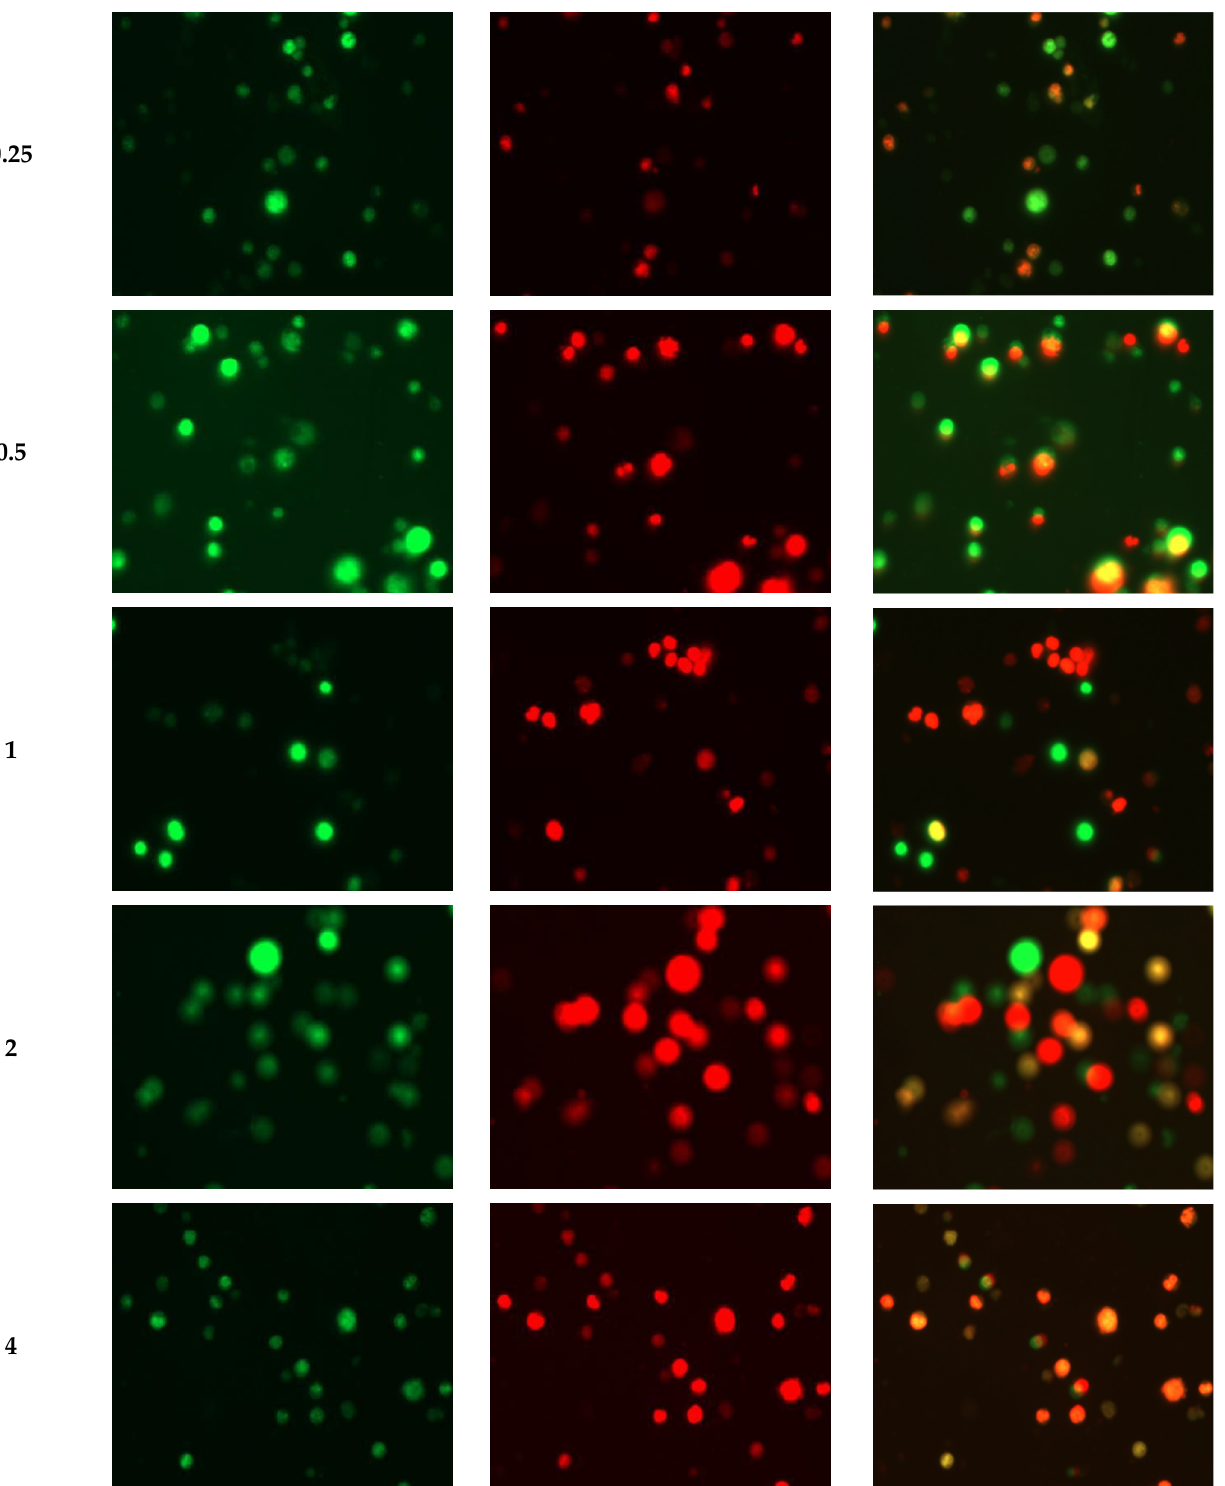
Figure 5. Effects of RHWPs on apoptotic morphological of S180 cells. S180 cells treated with the different concentration of RHWPs for 72 h. The cell suspension was stained with acridine orange (AO; 100 μ g/mL) and propidium iodide (PI; 100 μ g/mL). The stained cells were immediately observed under a fluorescence microscope. The live cells are green, apoptotic (orange), and necrotic (red) cells. Green fluorescence is the cells labeled by AO, while red fluorescence indicates the necrotic cells stained with PI. Orange fluorescence indicates apoptotic cells.